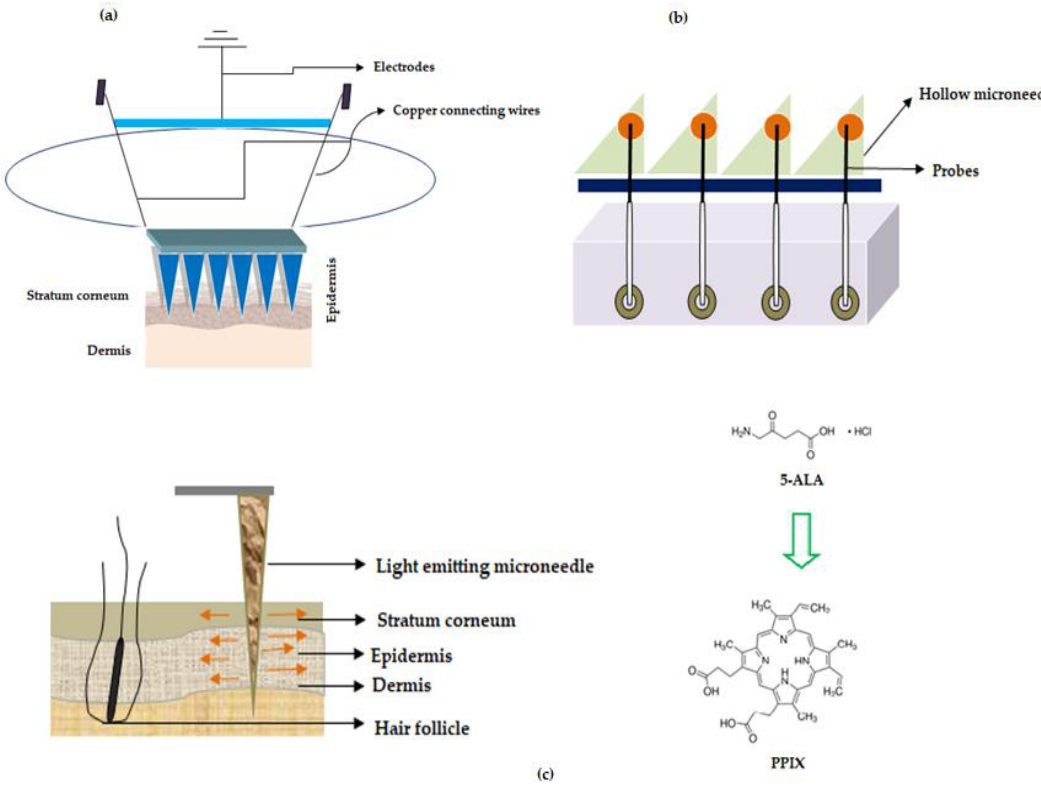
Figure 6. Microneedles for treatment of cancer ( a ) Illustration showing MNs with sensor unit when applied to skin ( b ) Microneedle array device with probe ( c ) Light emitting fiber optic microneedle converting 5-Aminolevulinic acid (5-ALA) to Protoporphyrin IX (PPIX).